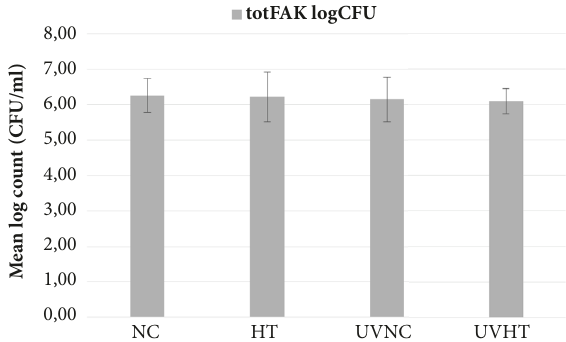
Figure 5: Mean logarithmic CFU counts ( ± SD) of total facultative bacteria in the plaque collected from the studied materials: Non coated titanium alloy (NC), hydrothermally induced TiO 2 coating (HT), UV treated non-coated titanium alloy (UVNC) and UV treated titanium alloy with hydrothermally induced TiO 2 coating